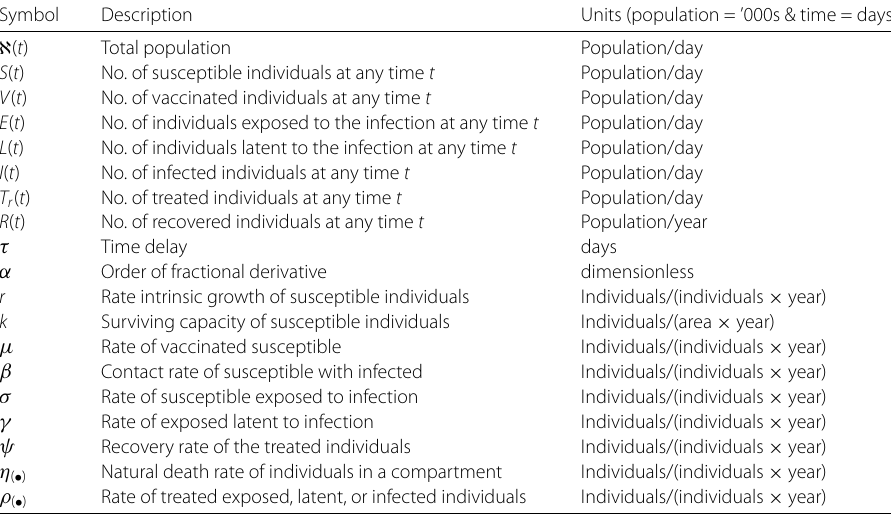
Table 1 Details of symbols of SVELITR model (6)